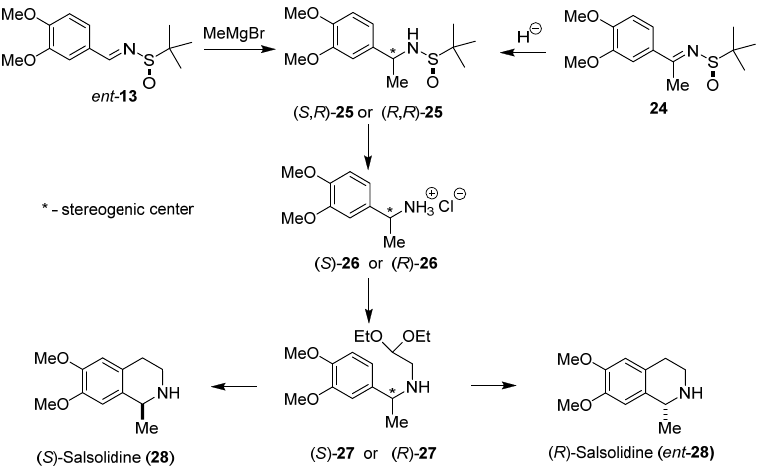
Scheme 6. Diastereoselective synthesis of ( S )- and ( R )-salsolidine ( 28 and ent - 28 ) using sulfi- nylimines ent - 13 and 24 , respectively, as